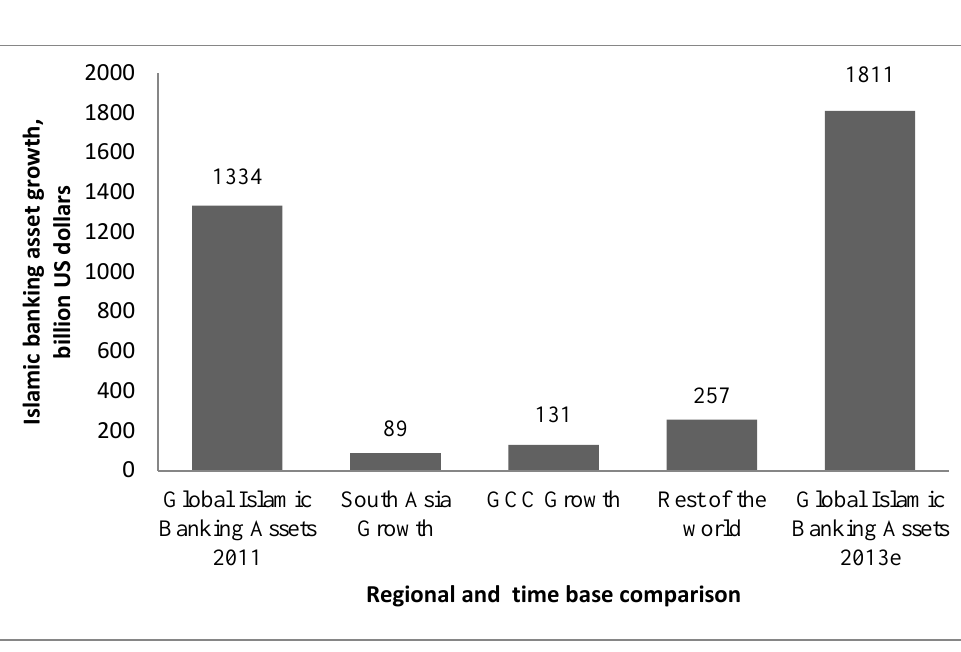
Fig. 1. Islamic banking asset growth in billion US dollars. (Calculation by the authors ). Table 1. Top 10 global banks in Islamic